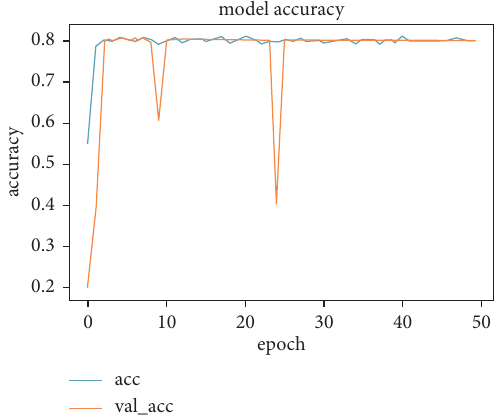
Figure 20: The accuracy rate of action idea EEG in dynamic state during model training.